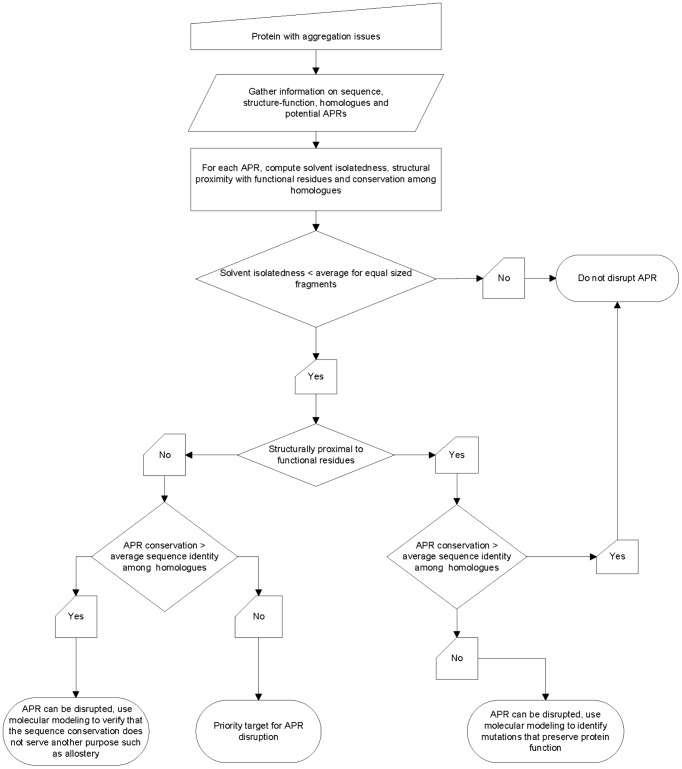
A general strategy for identifying mutation sites to improve protein solubility via disruption of APRs is shown.This strategy calls for an evaluation into the contributions made by candidate APRs towards the stability and function of a protein before deciding to disrupt it for the purpose of improving protein solubility. The following guidelines for rational disruption of APRs have emerged from this study. (i) If the candidate APR is buried in the protein core and contributes to the stability of the protein, then it should not be targeted for disruption. (ii) If the APR is located at or near the protein surface, is highly solvent exposed, not in contact with functional residues and is also less conserved than the average sequence identity among homologues to the parent sequence, then it is a priority target for disruption. Outside these two extremes, additional intermediate situations are identified where disruption of a candidate APR via point mutations can improve protein solubility without impacting its stability or function.